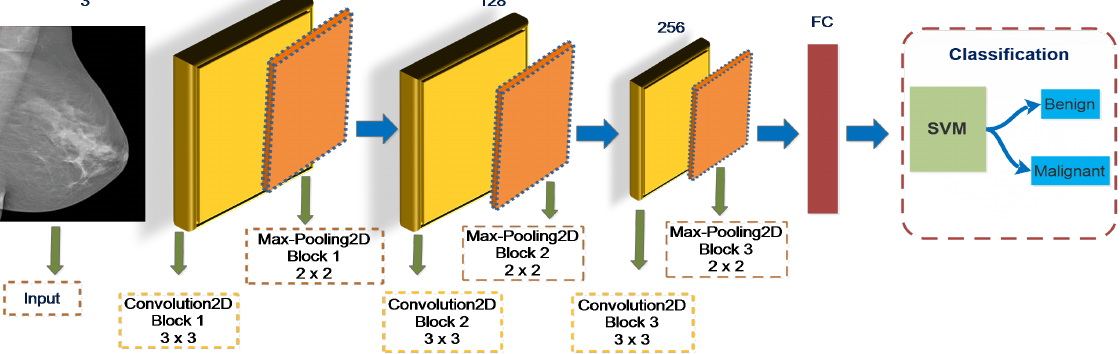
Figure 6. Features extraction from fully connected layer to be input into SVM